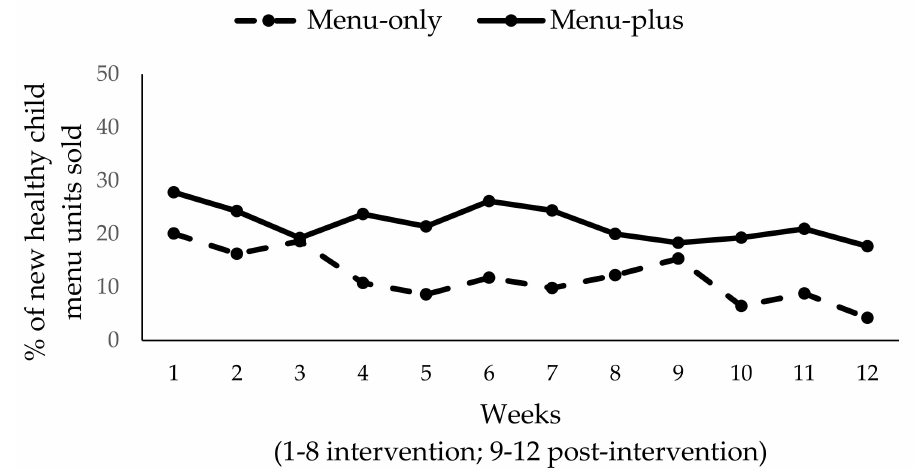
Figure 5. % of healthy child menu items (units) sold by condition ( N =